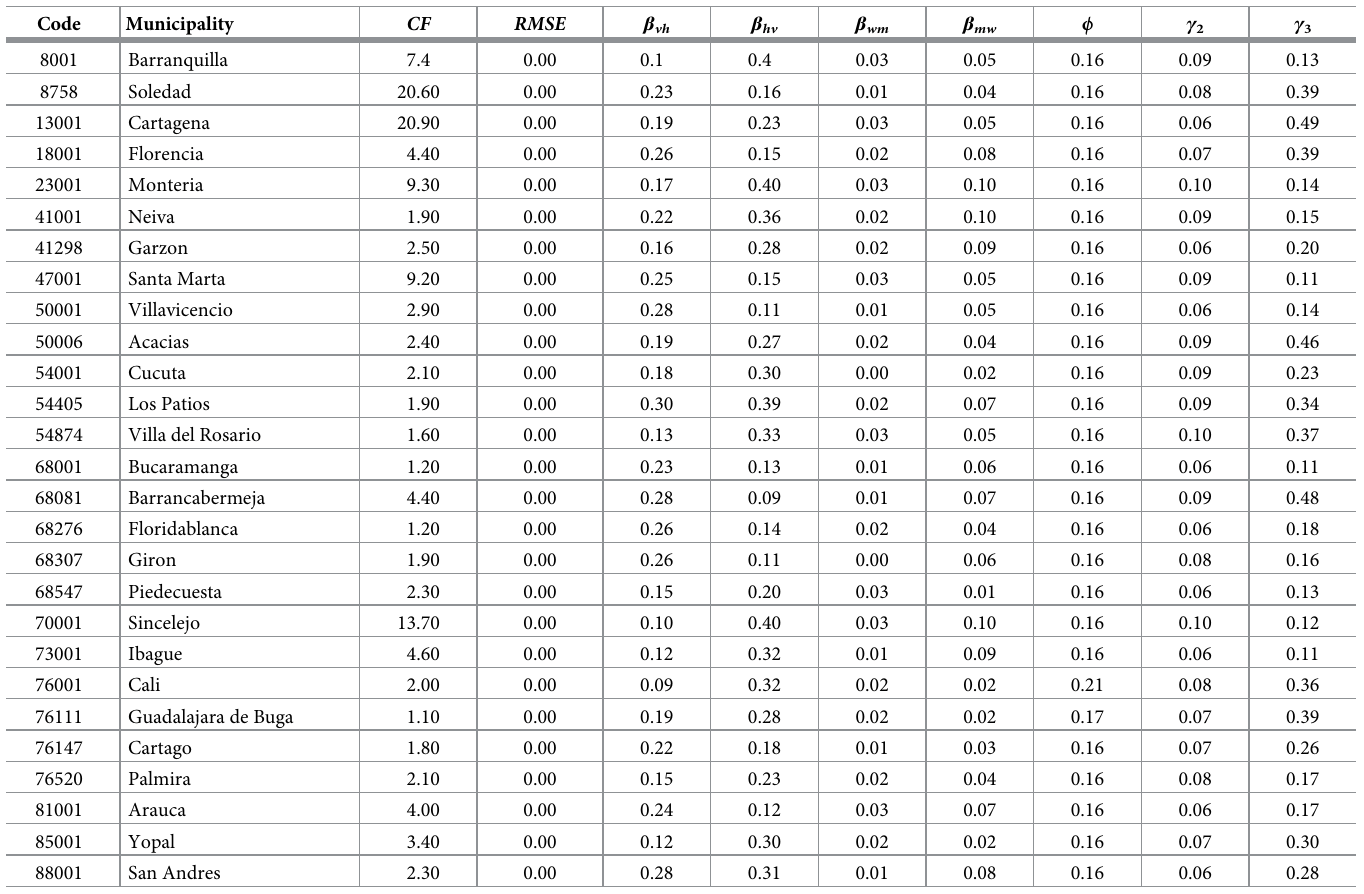
Table 3. Estimated errors, parameters, and correction factor for the symptomatic ZIKV infections.